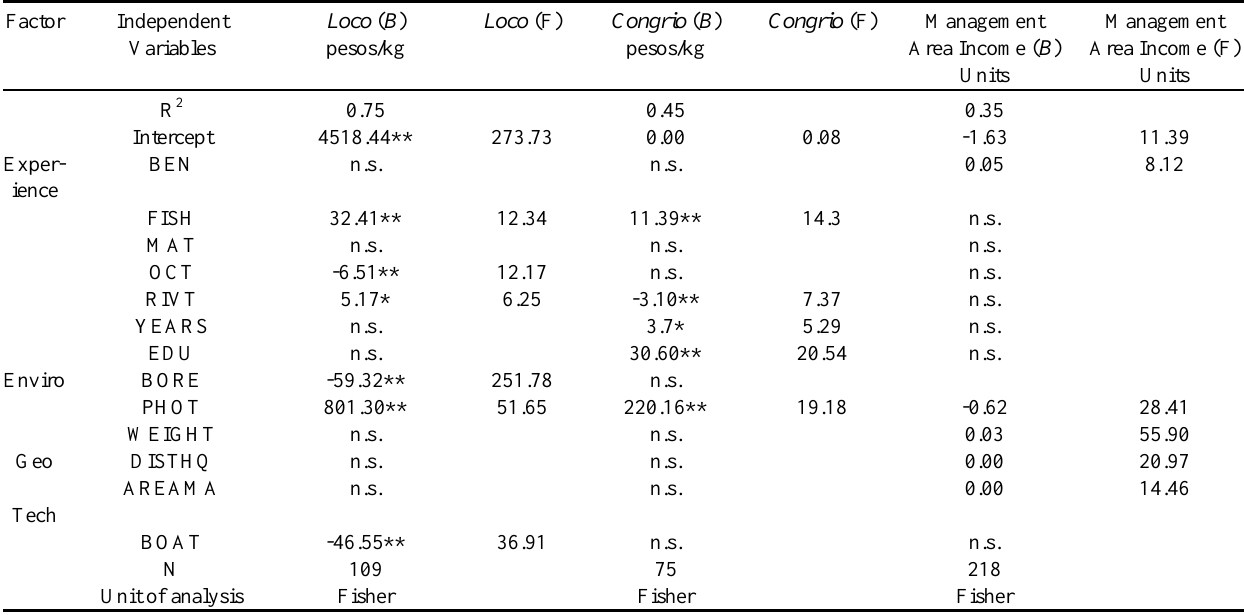
Table 5 . Regression models of loco price (pesos/kg), congrio price (pesos/kg), and monthly income (pesos/mo) in the 2003 season. Only significant independent variables used in the analysis are shown in column 1 (see Table 1 for full list of independent variables).